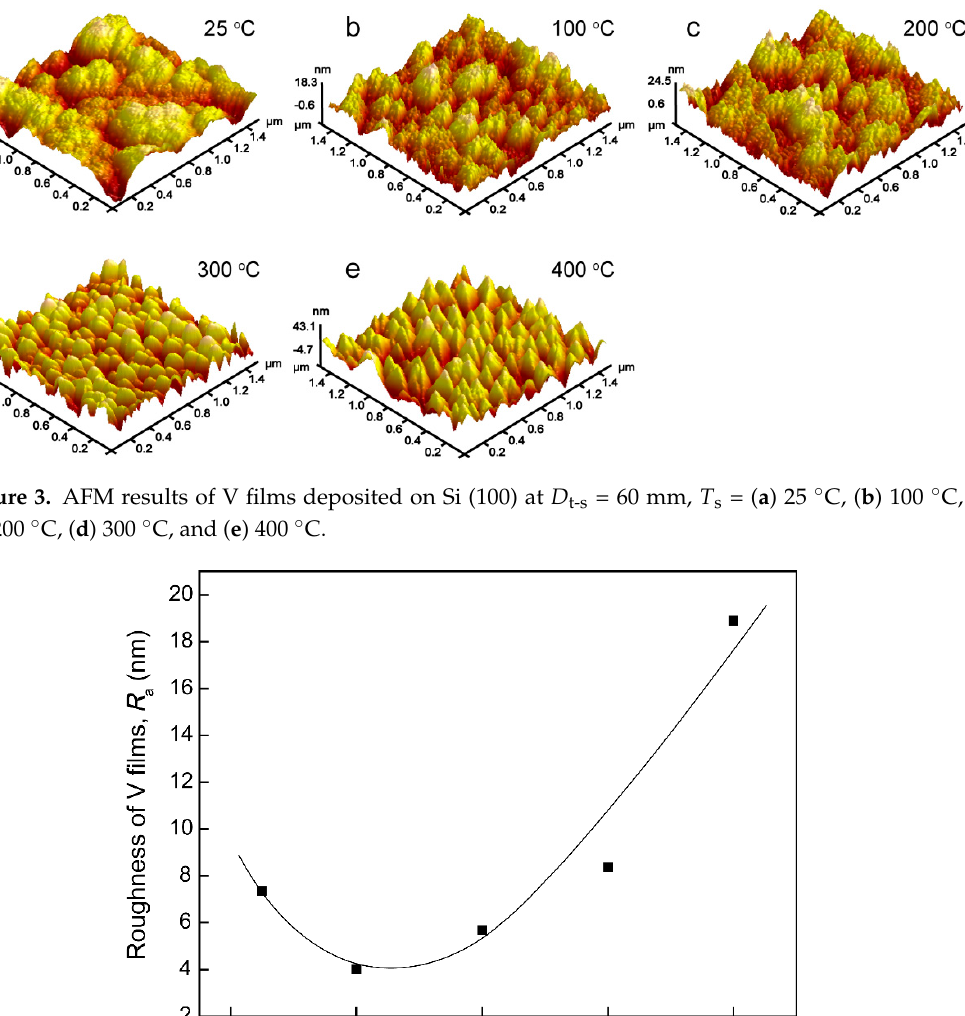
Figure 2. SEM images of the V films deposited on Si (100) at D t-s = 60 mm, T s = ( a ) 25 °C, ( b ) 100 °C, ( c ) 200 °C, ( d ) 300 °C, and ( e ) 400 °C.